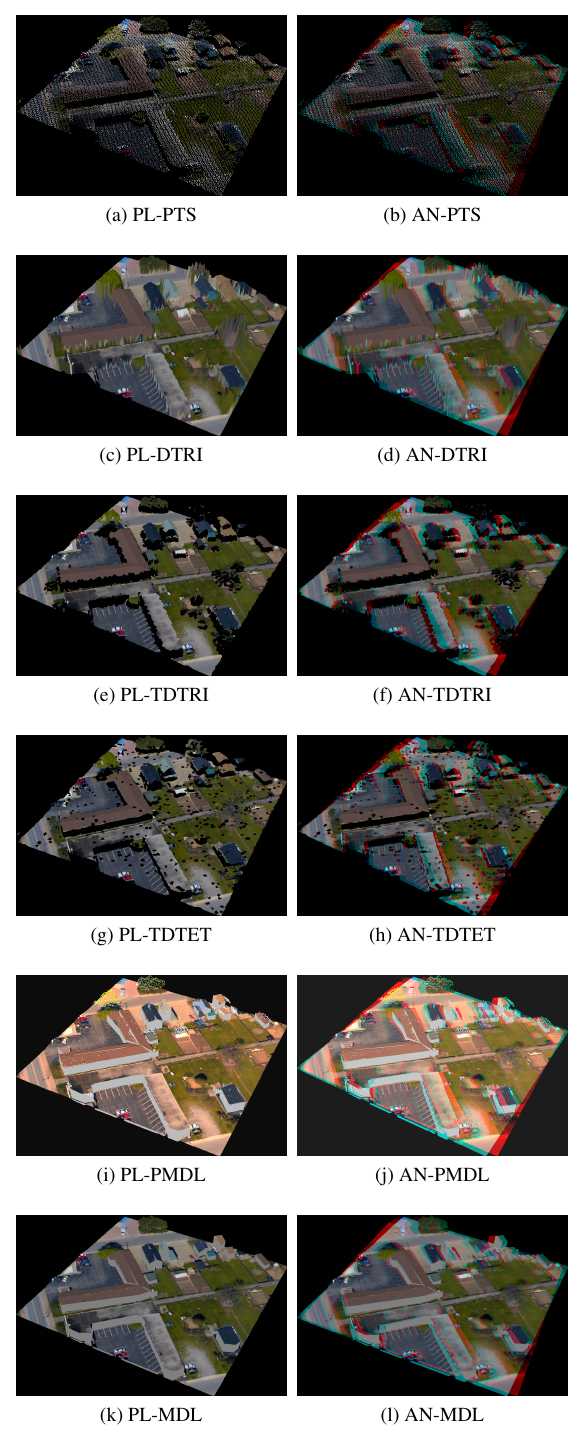
Figure 2: Various visualization schemes presented to the partici- pant. Screenshots are presented for a single data subset